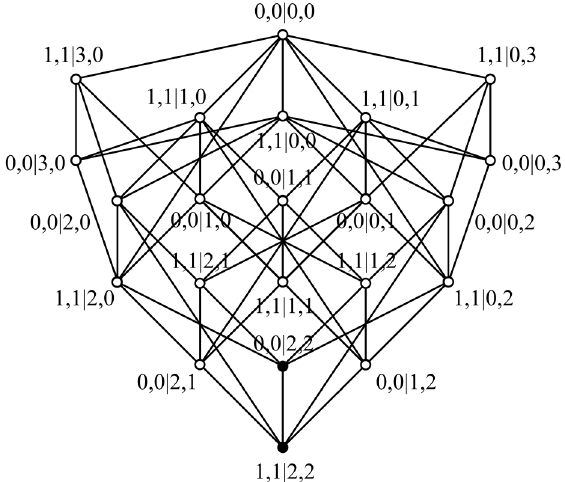
FIG. 3. Vertex-weighted graph of exclusivity for the events in the Bell inequality A s in Eq. (60). There are 26 events. Black 4 nodes represent vertices with weight 2 in Eq. (60) and white nodes represent vertices with weight